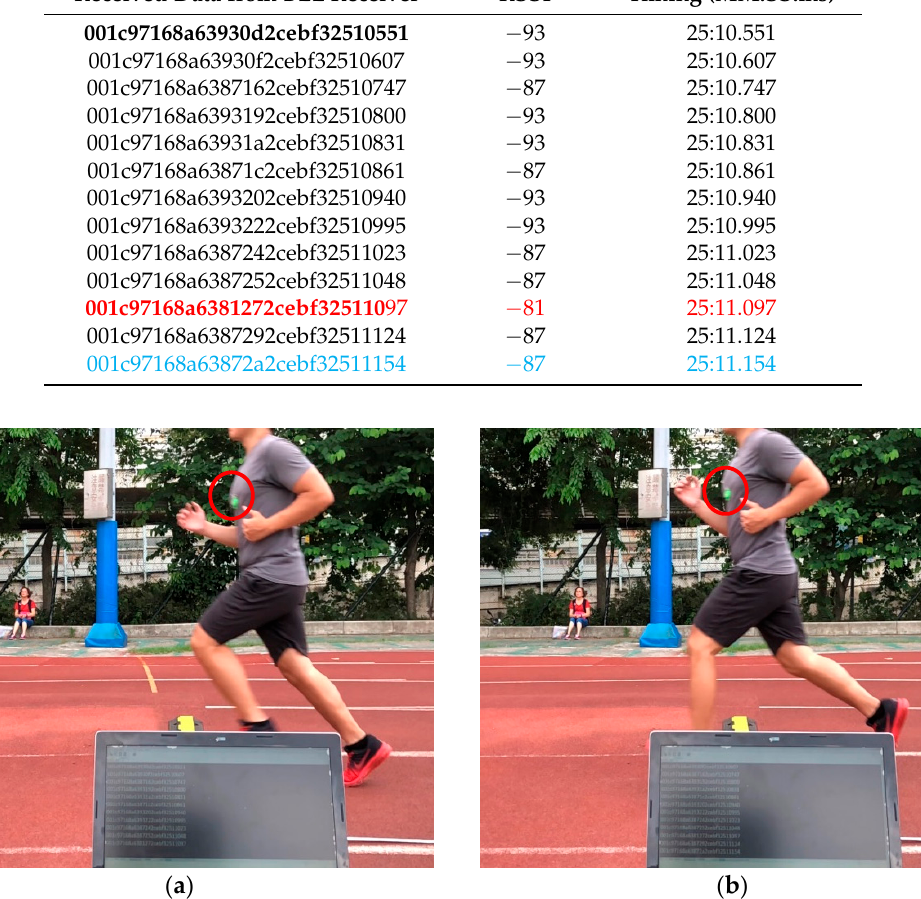
Figure 13. The dynamic experiment to test the RSSI related to the different runner locations. ( a ) Shows the time at which the biggest RSSI was received. ( b ) Shows the time of the BLE Tag on top of the mat. Table 1. One dynamic experiment in which the BLE Tag was on the chest.